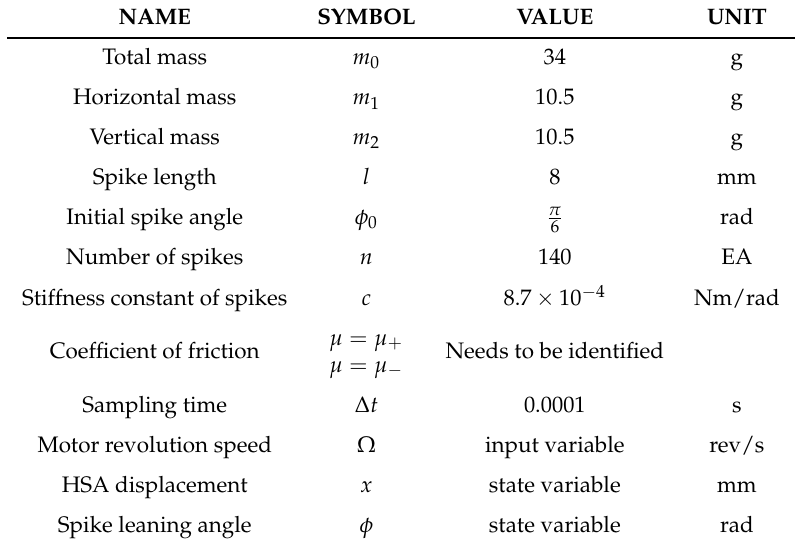
Table 1. The definition of the variables and parameters appearing in Figure 3. rev,